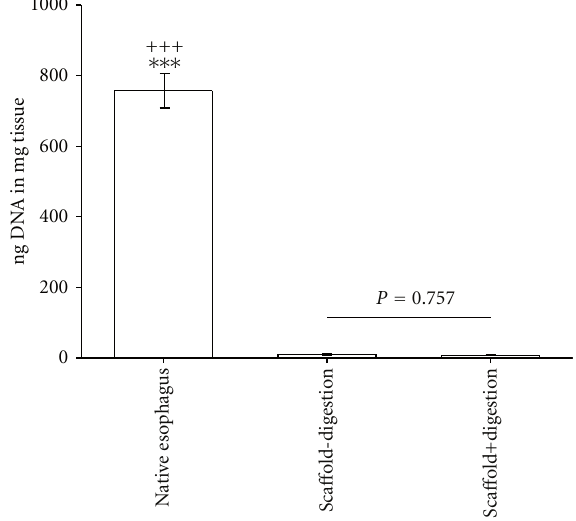
Figure 3: The comparison of remaining DNA content in decellular- ized esophageal tissue with and without DNA digestion (both n = 6). Significant di ff erences between both groups do not exist ( P = n . s.). Native, untreated esophageal tissue served as control ( n = 6). ∗∗∗ = P < 0 . 001 versus decellularized esophagus without DNA digestion group. +++ = P < 0 . 001 versus decellularized esophagus with DNA digestion